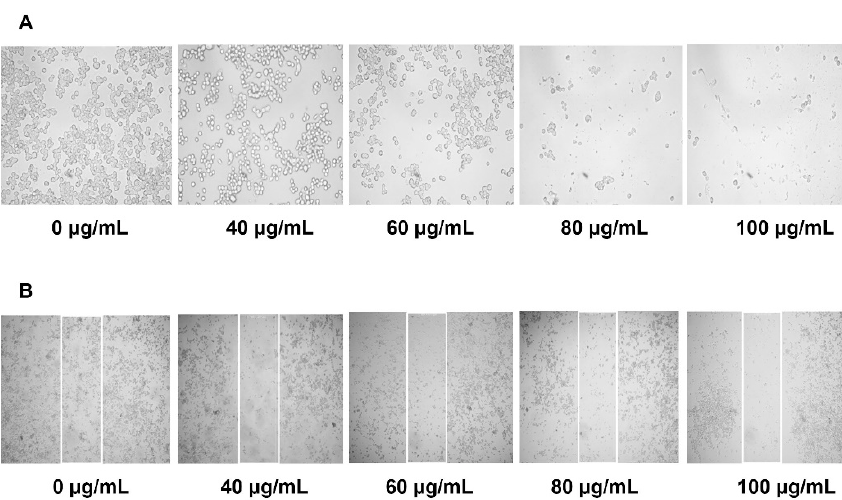
Figure 3. Effect of YLE on ( A ) cell morphology and ( B ) migration ability of HepG2 cells. The figures show one of three independent experiments.